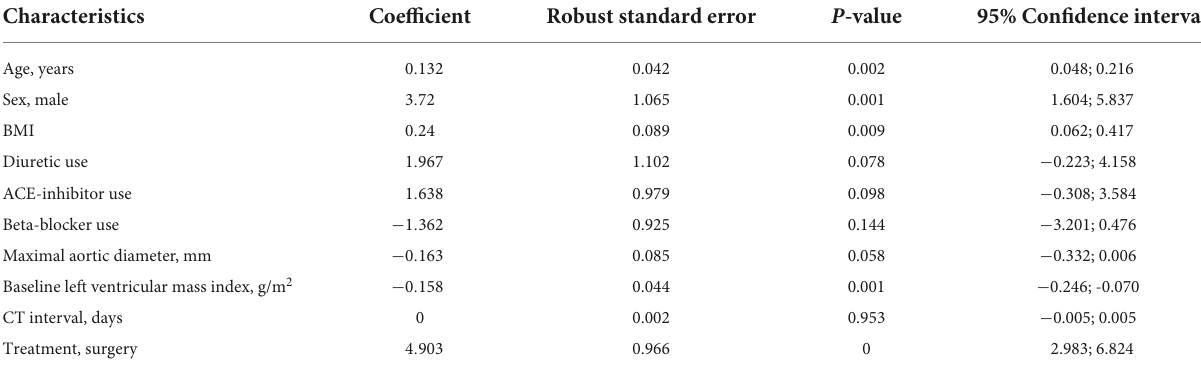
TABLE 4 Multivariate regression analysis with left ventricular mass index (LVMI) change as the dependent variable. Characteristics Coefficient Robust standard